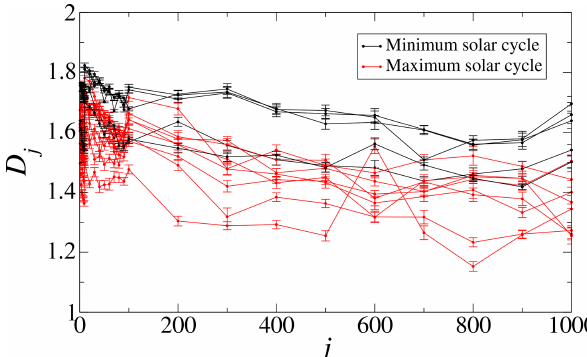
Figure 7. Box-counting dimension of magnetic forcing term ˜ f b (t) for different values of j . Curves are distinguished for years corre- sponding to maximum (black lines: years 1998 to 2005) or mini- mum (red lines: years 1996, 1997, and 2006 to 2008) of the solar